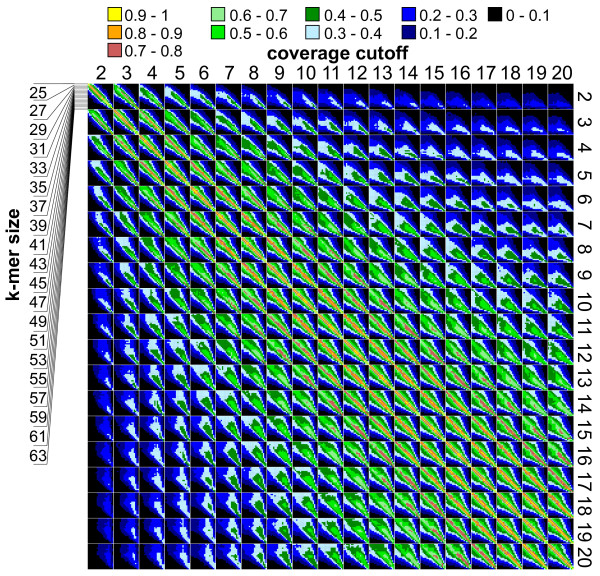
Amount of overlap between complete transcripts identified in different assemblies of P. fastigiatum reads. 380 different assemblies were conducted using ABySS [25,26] and a combination of (i) coverage cutoffs between 2 and 20 and (ii) k-mer sizes between 25 and 63. Transcripts covering a complete coding sequence of the homologue from A. lyrata or A. thaliana were identified and counted. These were searched against each other and the number of sequences present in each of two assemblies was determined. The number of overlapping sequences was then divided by the sum of the number of sequences identified in both assemblies and again divided by 0.5 to obtain values between 0 and 1. These percentages were colour coded with yellow representing high values and darker colours low values. A black box means no overlap between the sets of complete transcripts.